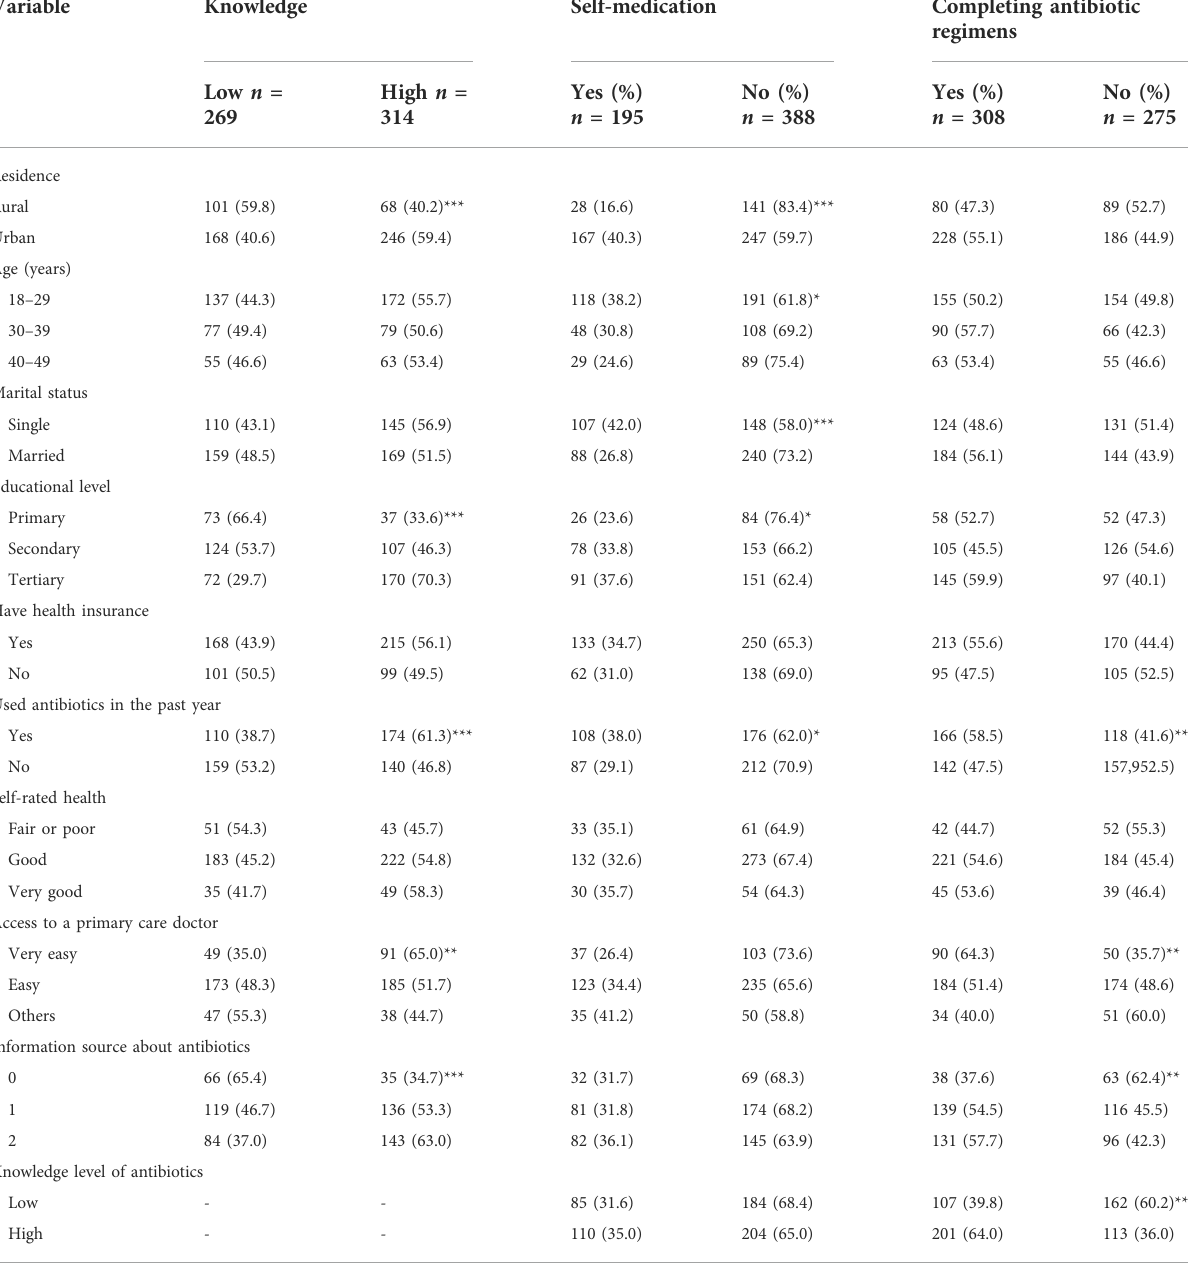
TABLE 3 Distribution of participants ’ characteristics by knowledge and antibiotic usage